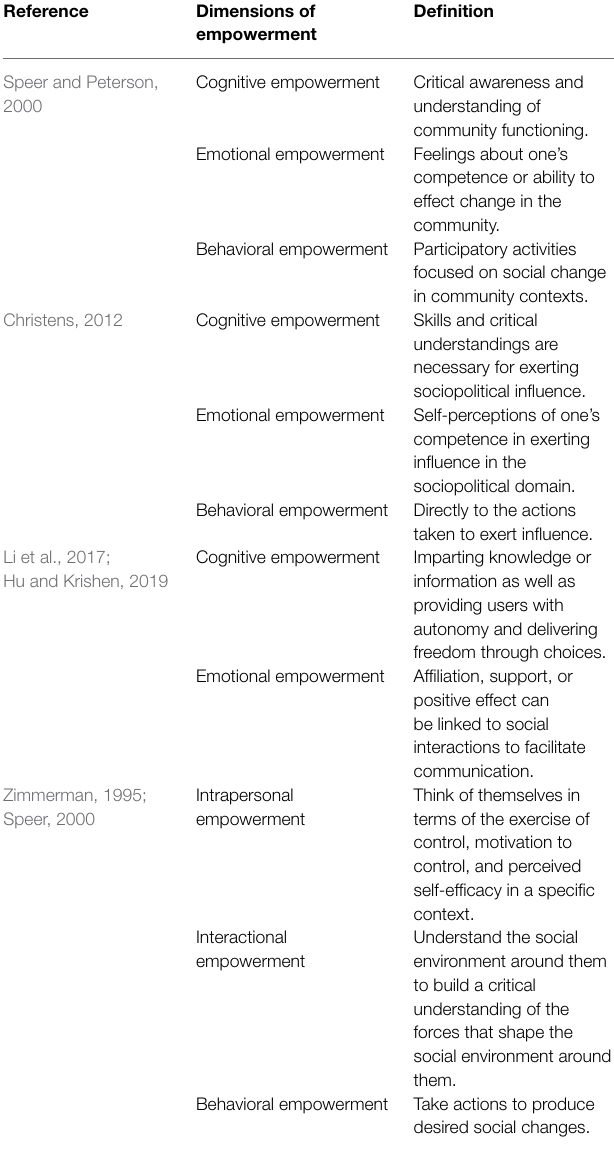
TABLE 1 | Summary of the dimensions of psychological